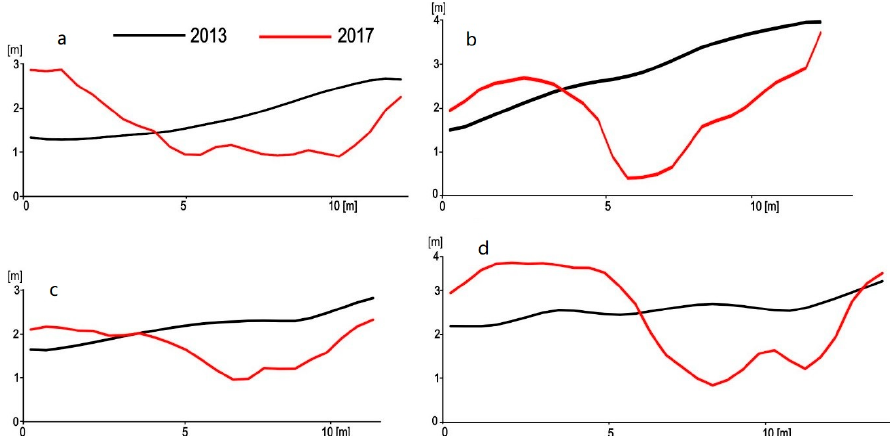
Figure 4. Cross section profiles within the analyzed forest road with embankments within the left-hand side of each profile; black line shows year 2013 (before road construction), red line shows year 2017 (after road abandonment). The road surface (red line) without clearly developed erosive cuts ( a , c ). The road surface (red line) with clearly developed erosive cuts ( b , d ). Locations of the profiles are marked on Figure 3.